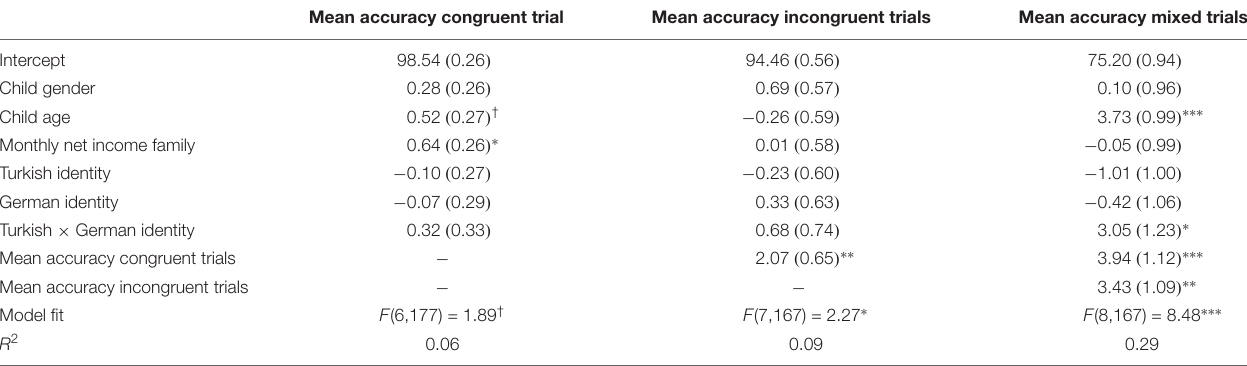
TABLE 1 | Standardized regression coefficients and standard errors of multivariate regression analyses.